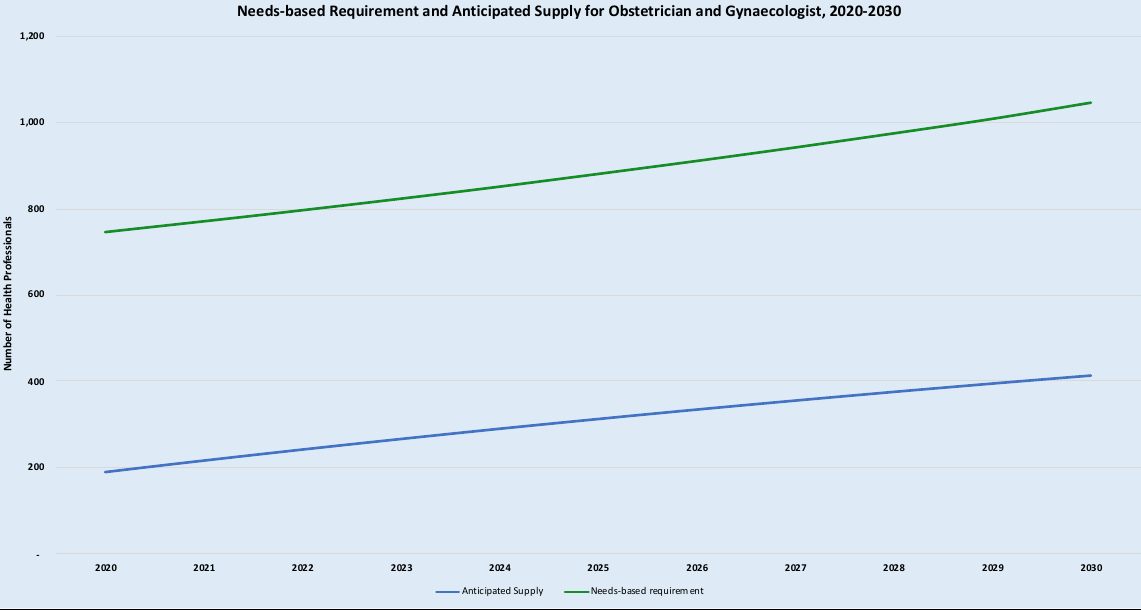
Figure 3. Needs-based requirements and anticipated supply of obstetricians/gynaecologists. Notes: Figure 3 illustrates the projected trend of the need-based requirement for obstetricians/gynaecologists (the green line) as compared to the anticipated trend of supply in the blue line.